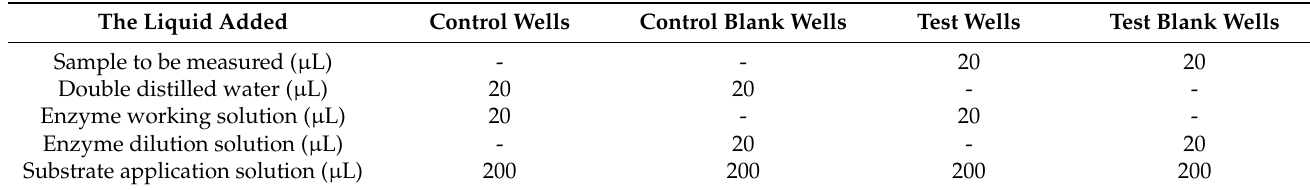
Table 1. Reagent composition of each well for SOD vitality detection.